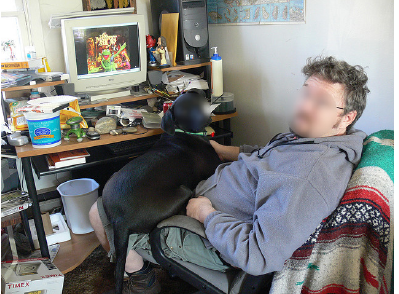
Figure 3. The words “couch” and “chair” are synonyms in the captions of an